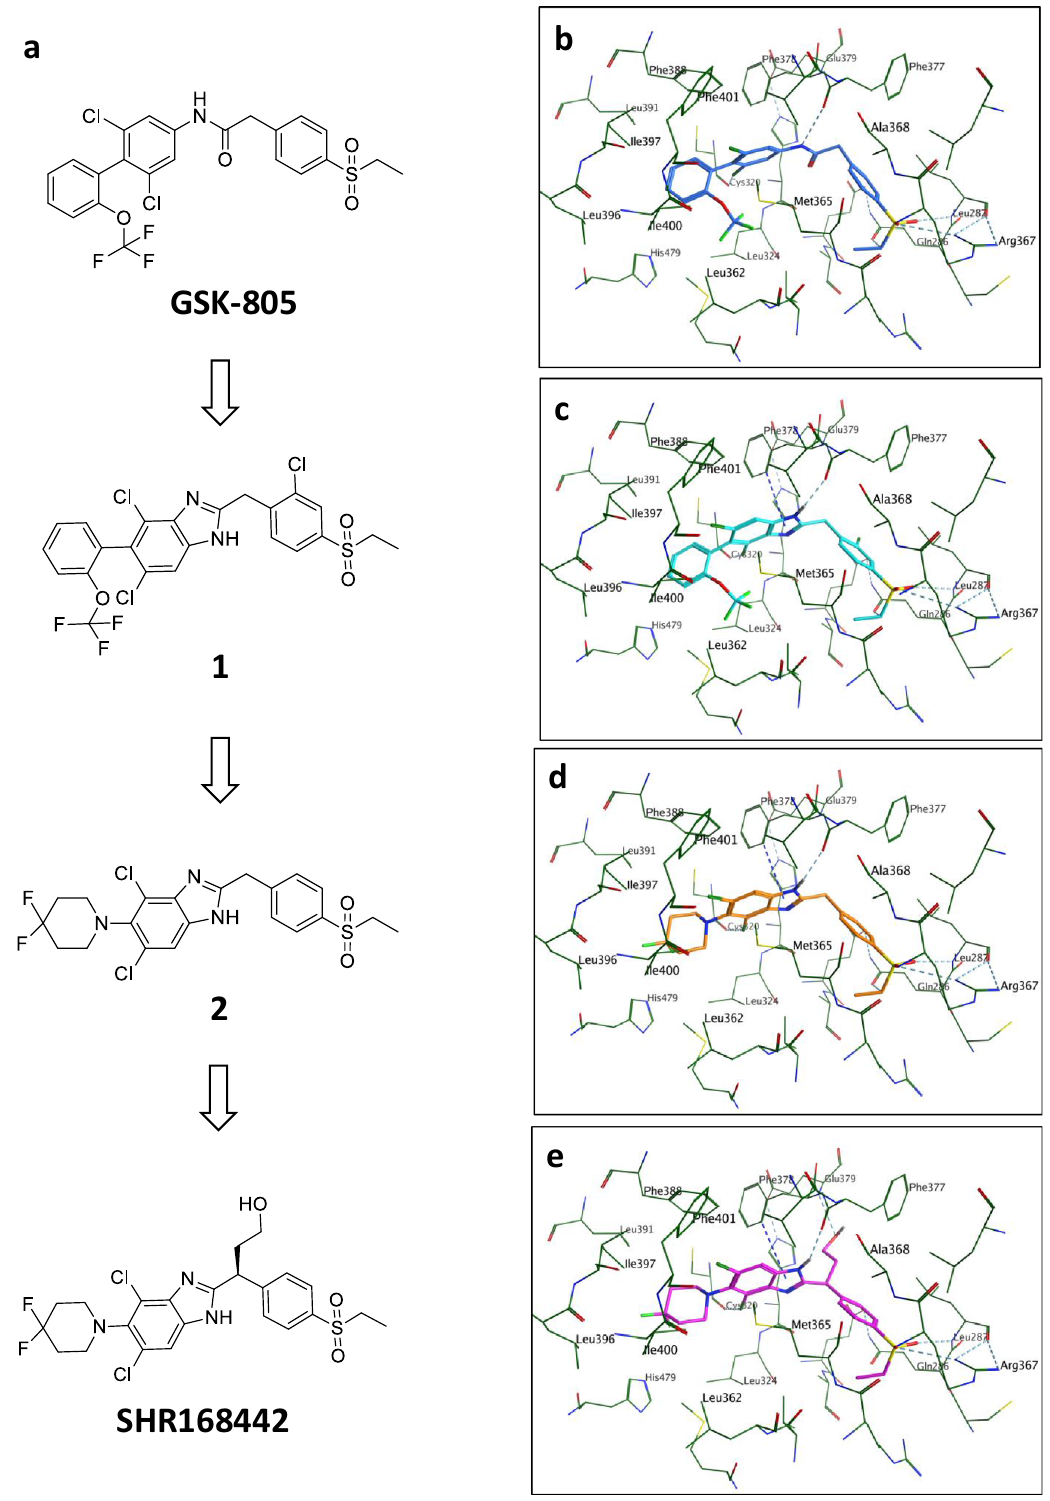
Figure 1. Identification of a novel series of benzimidazole as RORγ antagonists. ( a ) SAR scheme from identification of a novel chemical scaffold (Compound 1) derived from GSK805 to selected RORγ antagonists (Compound 2 and SHR168442) for skin-restricted exposure. ( b–e ) Modeled binding modes of RORγ antagonists in RORγ LBD colored in green from PDB (Accession number: 4NIE). ( b ) GSK805 colored in blue, ( c ) Compound 1 colored in cyan, ( d ) Compound 2 colored in orange, and ( e ) SHR168442 colored in